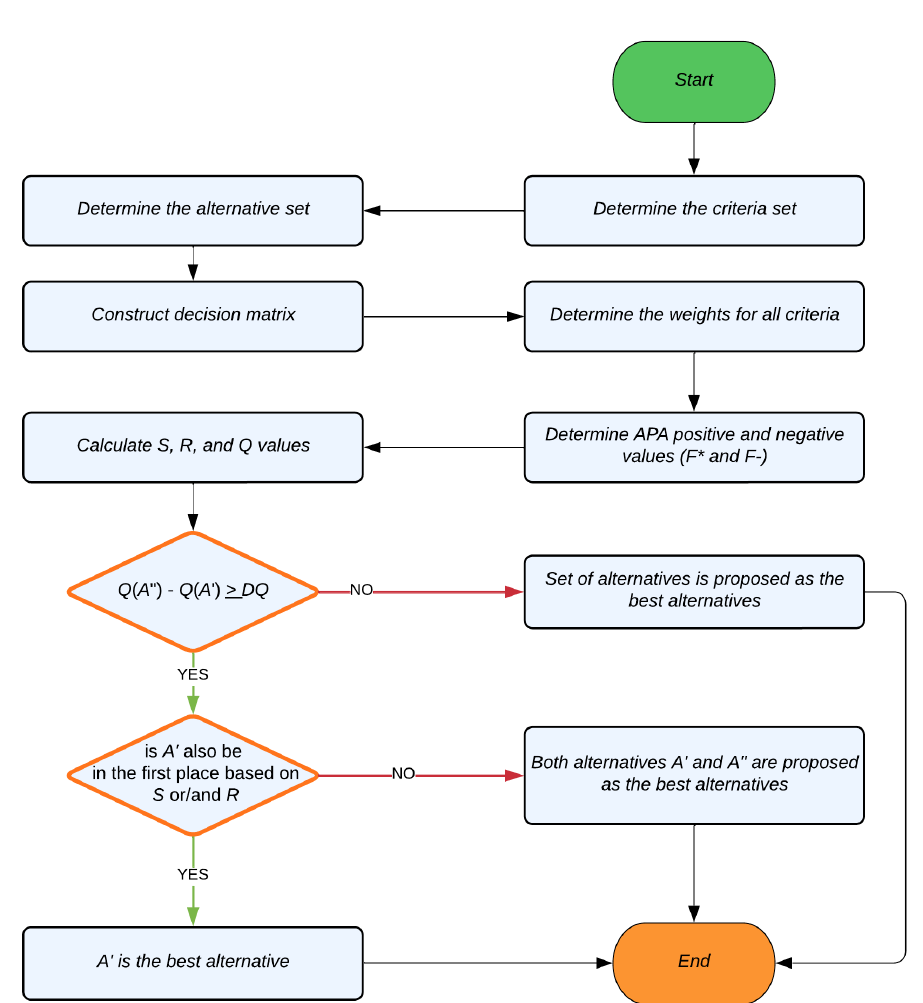
Figure 10. Flowchart of AHP – VIKOR methodology for evaluating satisfaction level.